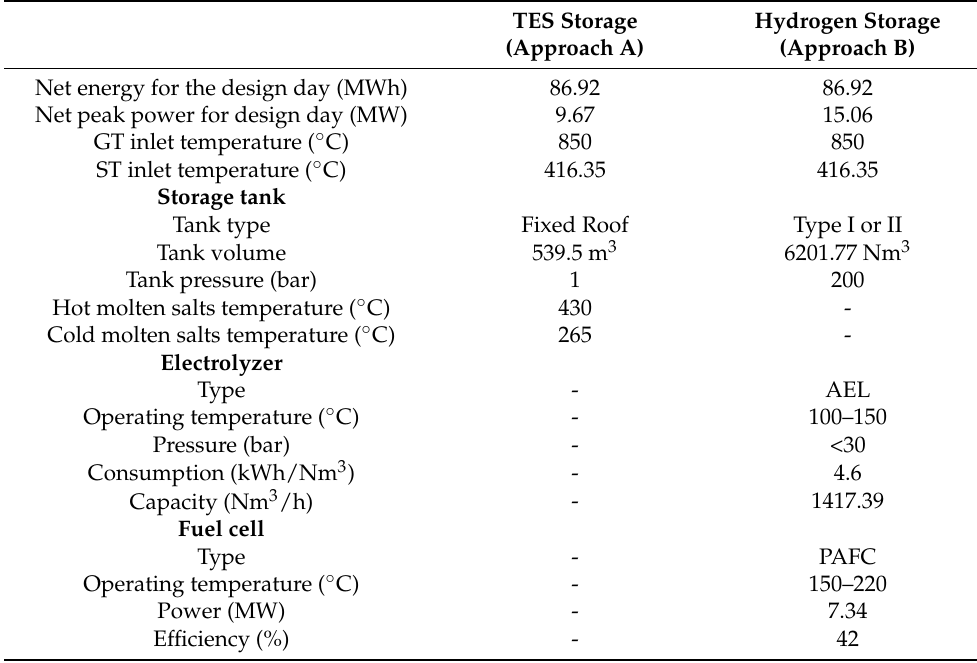
Table 4. Working conditions for the day of